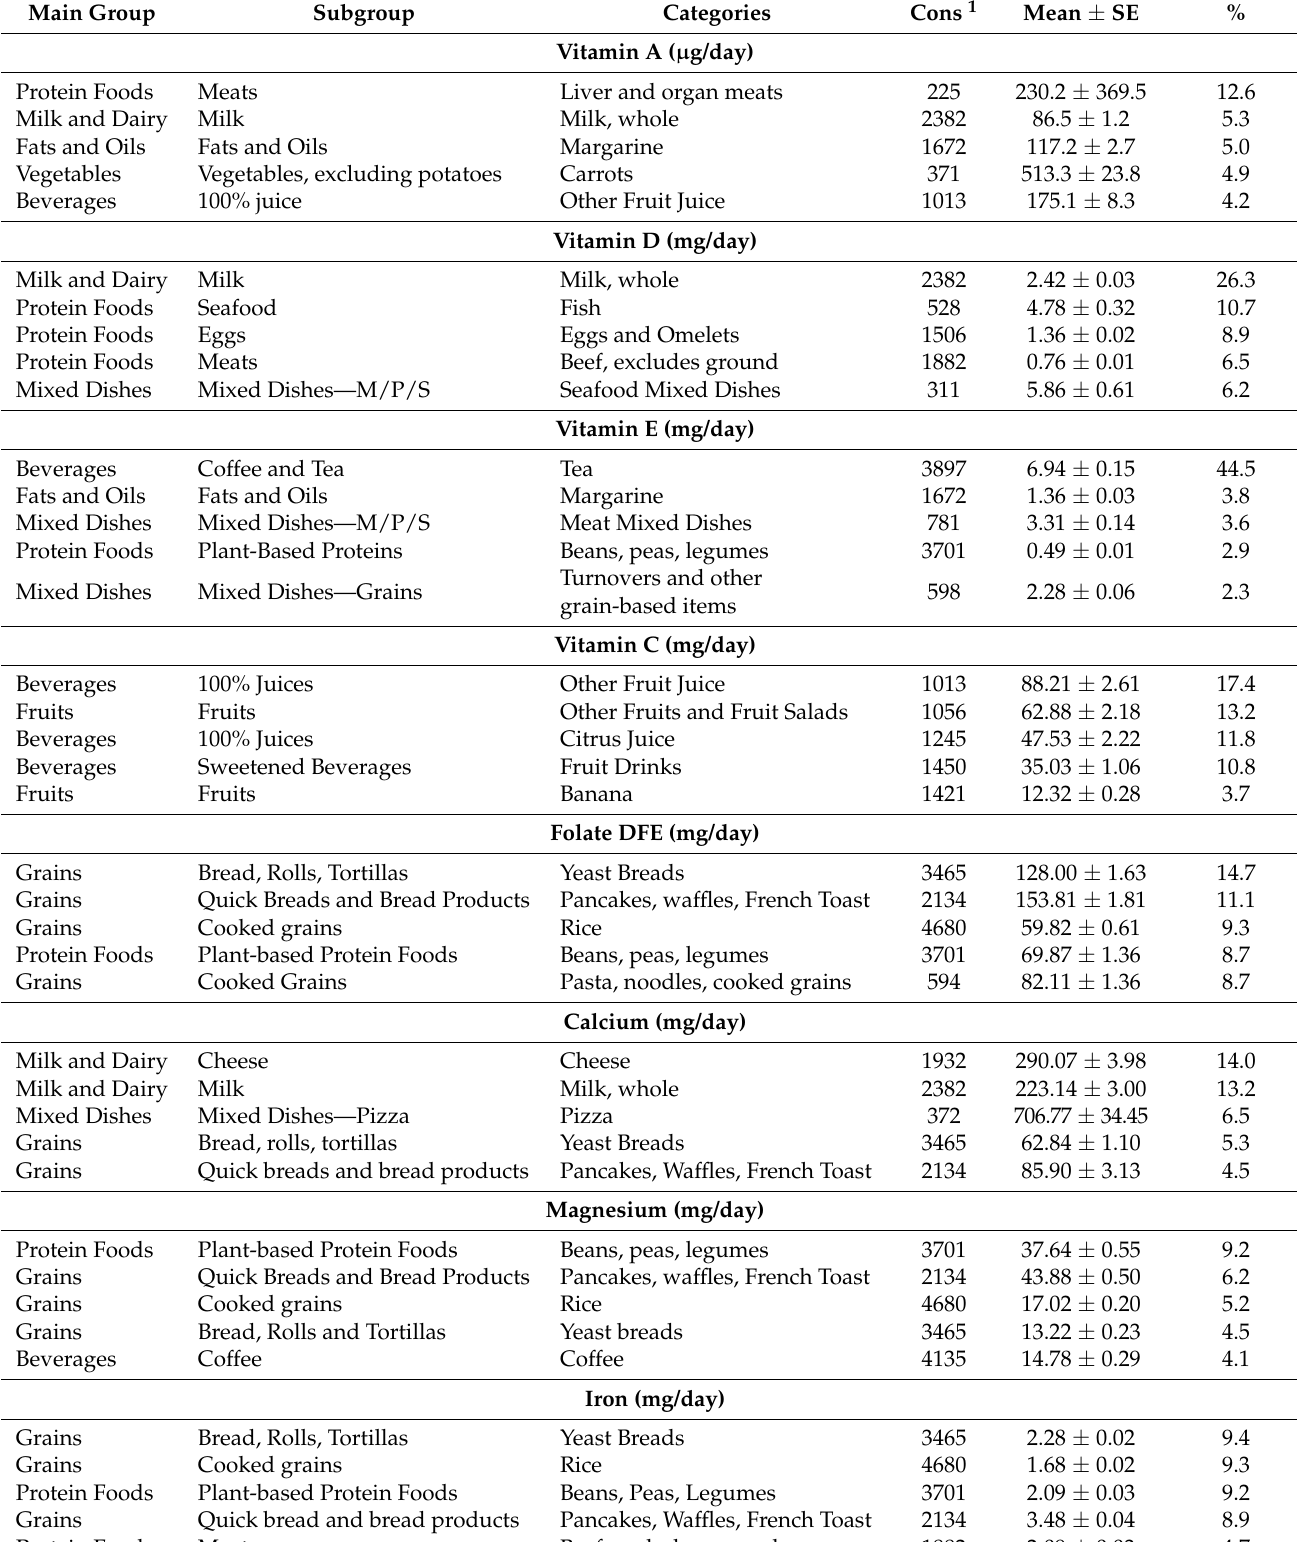
Table 2. Food sources of shortfall nutrients intake among Latin American adolescents and adults ( n = 9218). The Latin American Study of Nutrition and